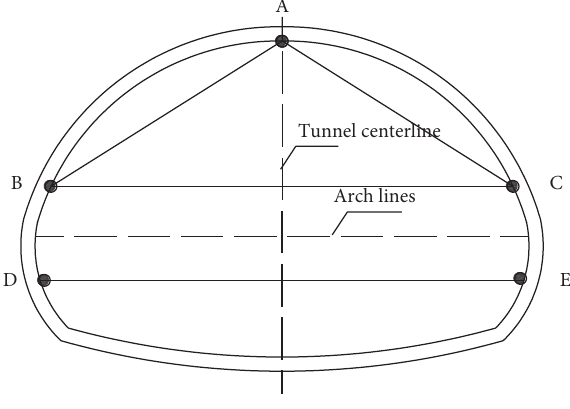
Figure 5: Layout of the monitored points. Table 1: Material